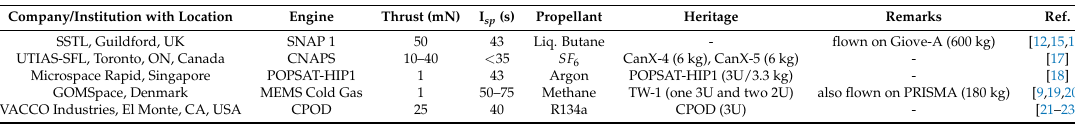
Table 1. Summary of Cold Gas Propulsion